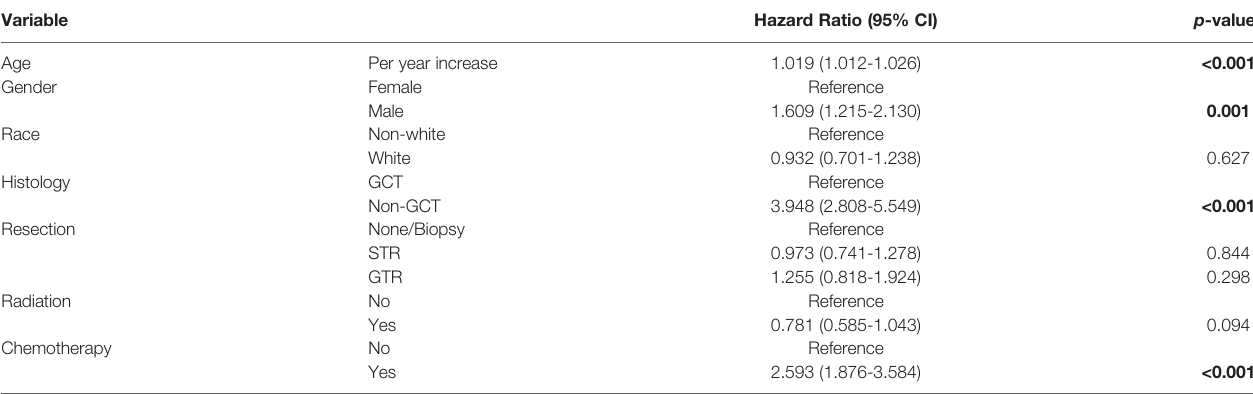
TABLE 2 | Multivariate Cox proportional hazards regression for all-cause mortality of pineal gland tumors. Variable